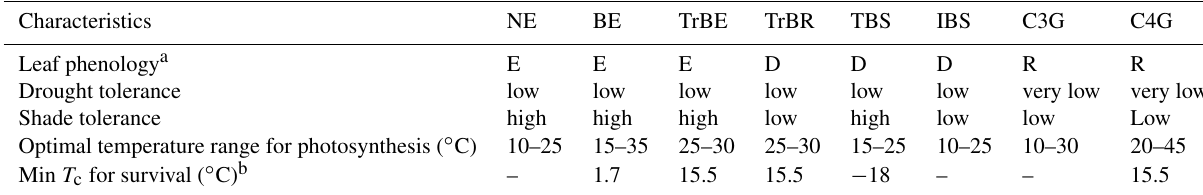
Table A1. Characteristics of the plant functional types (PFTs) used in the vegetation sub-model LPJ-GUESS.